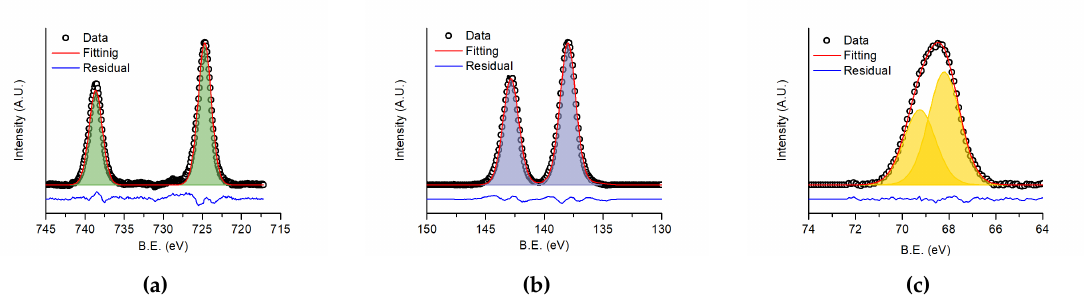
Figure 6. XPS spectra of ( a ) 3d transition of caesium, ( b ) 4f transition of lead and ( c ) 3d transition of bromine. The dots are the experimental data, the red line is the fitting curve and the blue line is the residual. Table 1. Binding energies and measured peaks area for Cs, Pb and Br as evaluated from XPS data. The measured atomic percentage refers to the absolute elemental content as detected by the